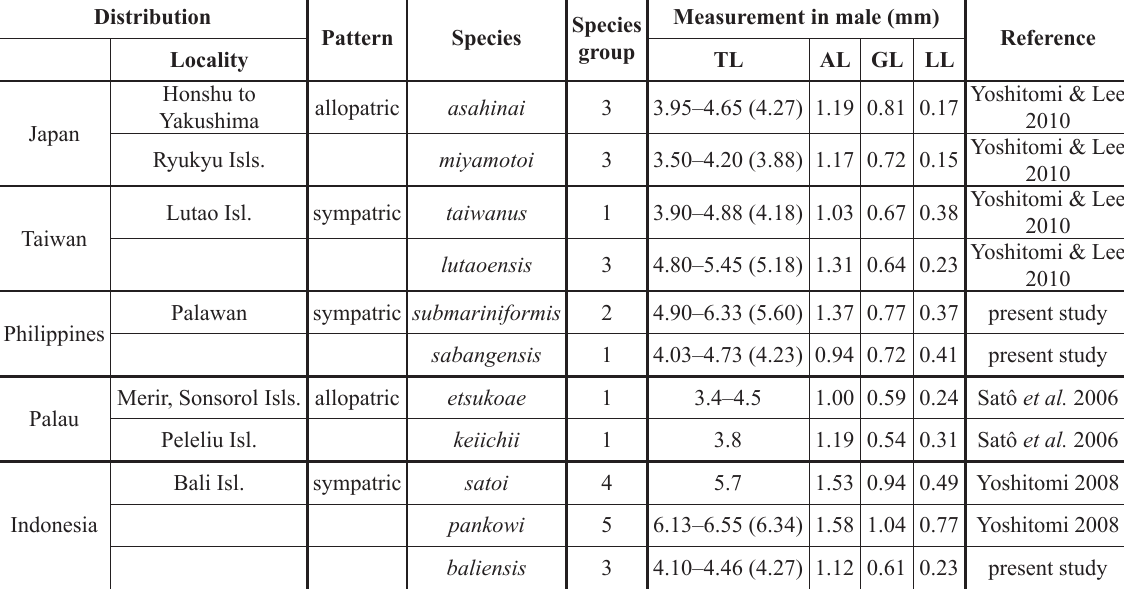
Table 1. Distribution of Laius spp. in five